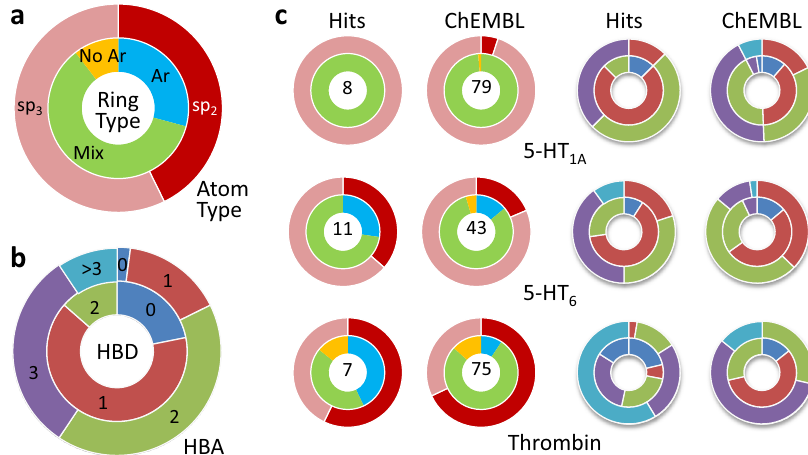
Fig. 3 Topological features of SpotXplorer0 hits vs. ChEMBL fragments. a Selection by pharmacophore results in a relatively even distribution of both ring types (Ar: only aromatic — light blue, Mix: both aromatic and non-aromatic — light green, No Ar: non-aromatic — yellow) and both atom types (sp2 hybridization — dark red, vs. sp3 hybridization — light red/salmon). b Overall hydrogen bond distribution of ligands in SpotXplorer0 resulting from pharmacophore matching (HBD: no. of H-bond donors, HBA: no. of H-bond acceptors; 0 — dark blue, 1 — red, 2 — light green, 3 — purple, >3 — light blue). c Comparison of SpotXplorer0 hit compounds and ChEMBL fragments for selected targets. Each of the targets shown selects non-overlapping ring subsets: 5-HT 1A : mixed ring types with high sp 3 character and few hydrogen bond sites; 5-HT 6 : fl atter rings, more aromatic character with moderate hydrogen bond site counts; Thrombin: non-aromatic sp 2 rings with higher hydrogen bond site counts (Colors are identical to panels a and b